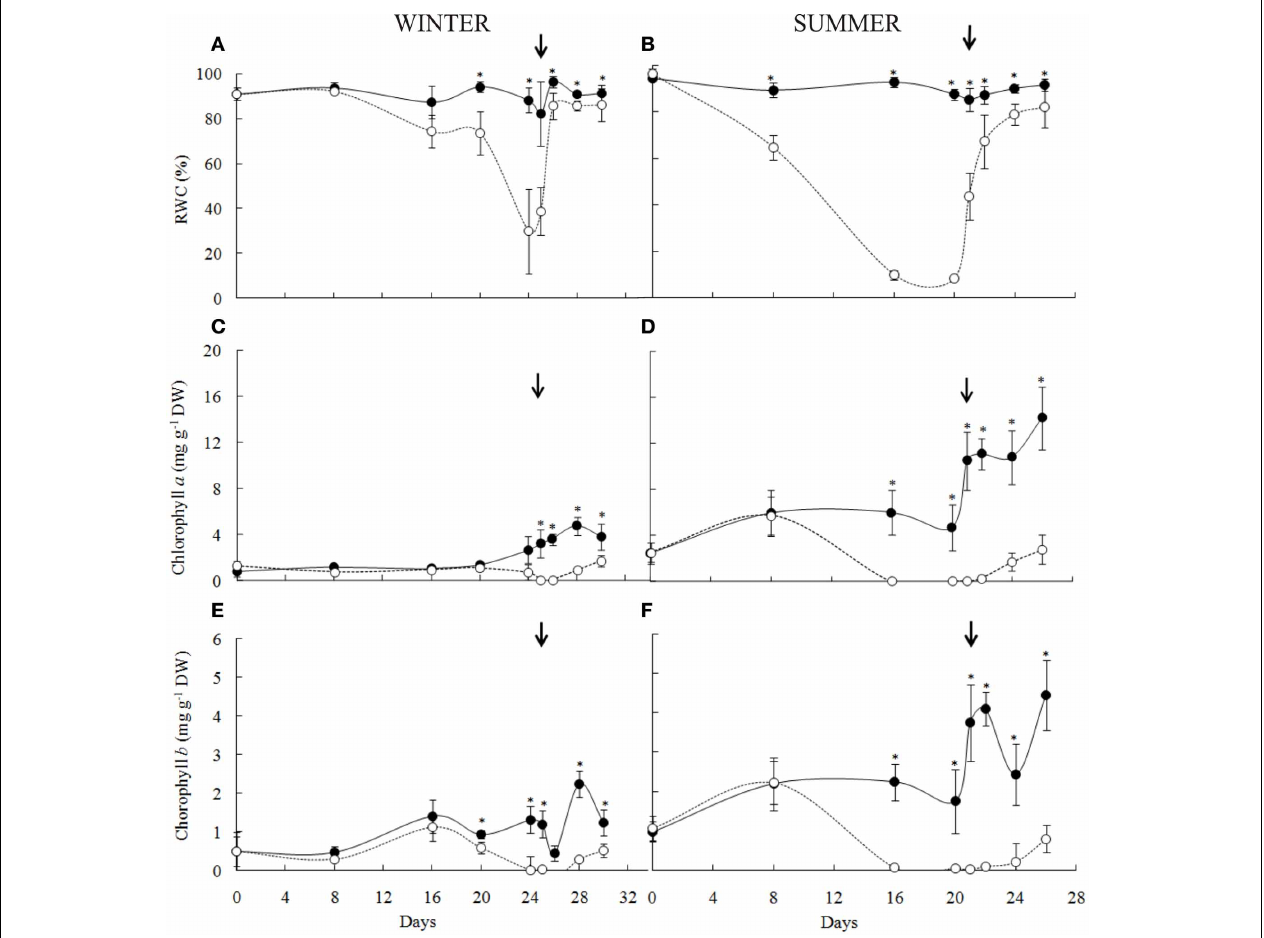
FIGURE 3 | Ecophysiological parameters of Barbacenia purpurea during dehydration and rehydration. Leaf relative water content (A,B) , chlorophyll a (C,D) andchlorophyll b (E,F) inleavesofdailywateredplants(controlgroup— • )